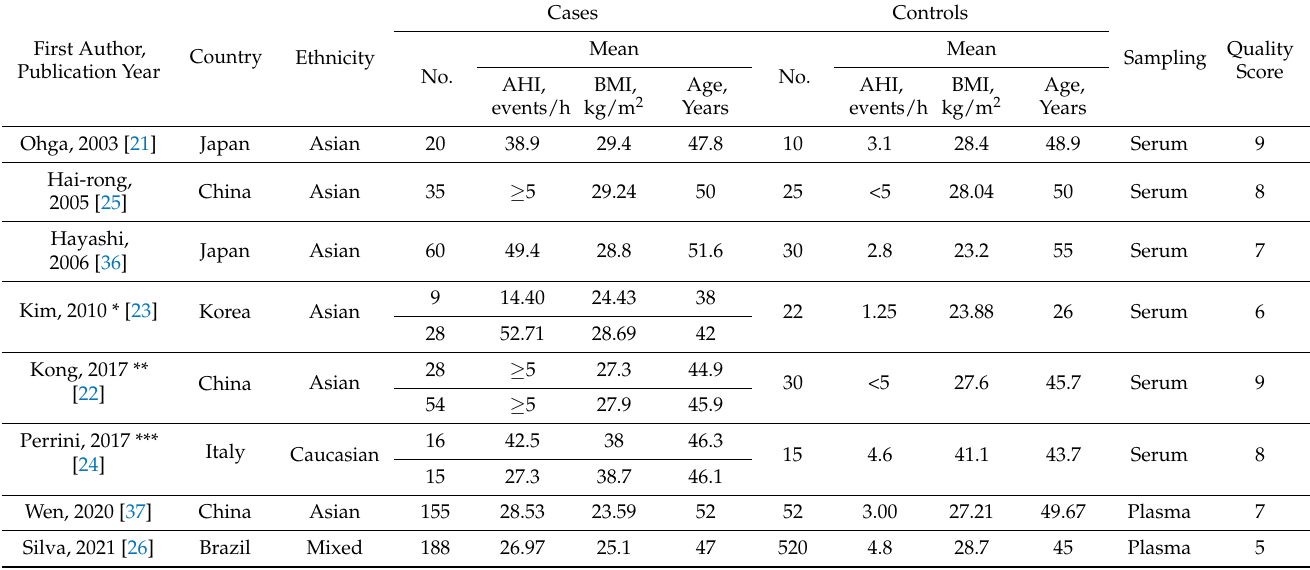
Table 1. Characteristics of